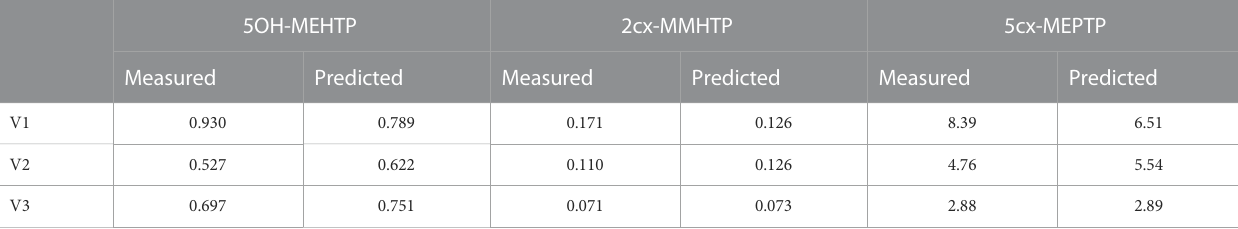
TABLE 6 Comparisons of predictions and measured 48-h eliminations of 5OH-MEHTP, 2cx-MMHTP and 5cx-MEPTP for the three volunteers under the posterior mode parameter